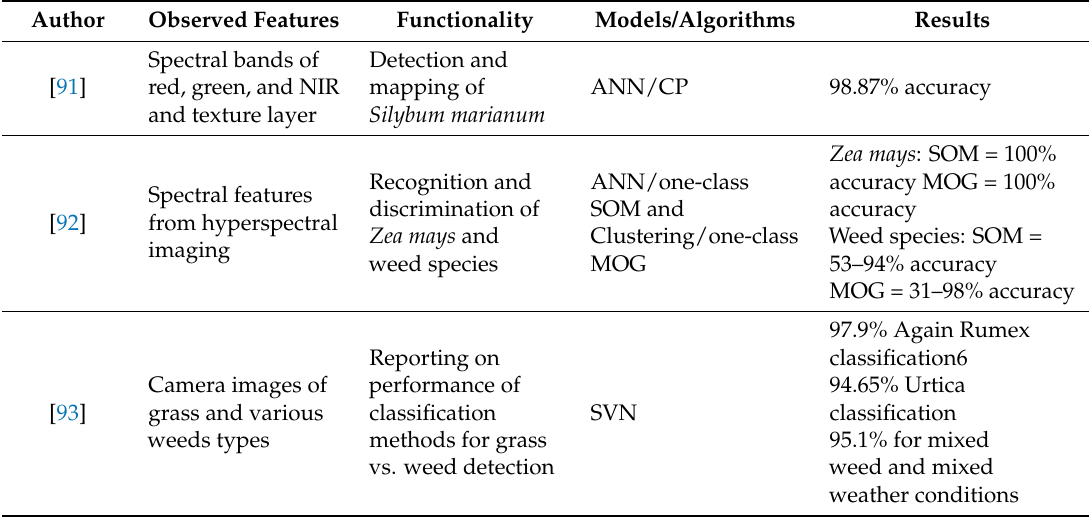
Table 7. Crop: Weed detection